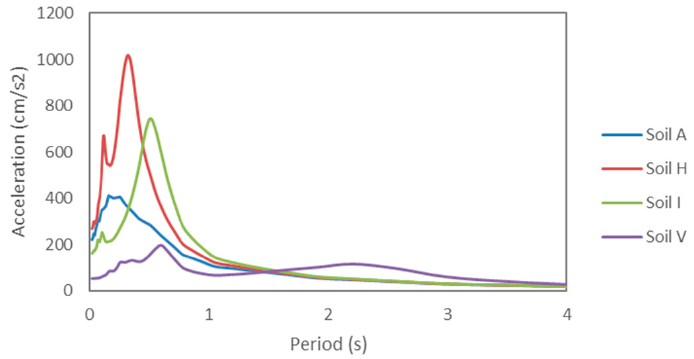
Figure 10. Response spectra associated with seismic scenario 5 (return period of 475 years) for the four ground types.